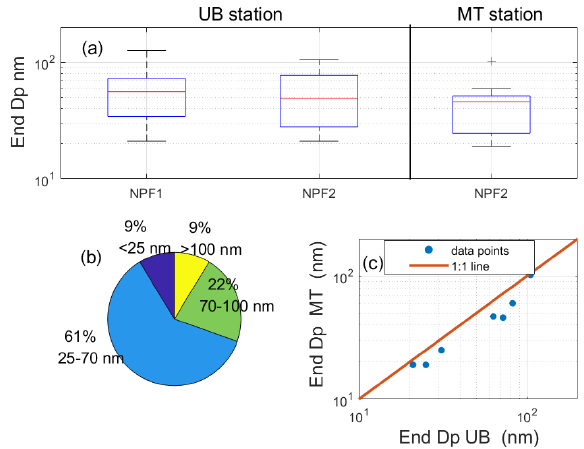
Figure 12. (a) Median and percentiles of end diameters (End Dp; nm) of NPF events measured at both sites. The red line represents the median of the data, and the lower and upper edges of the box represent 25th and 75th percentiles of the data, respectively. The length of the whiskers represents 1.5 times the interquartile range, which includes 99.3% of the data. “NPF1” and “non-event1” refer to NPF event and non-event days in summer 2018 and 2019, and “NPF2” and “non-event2” refer to NPF event and non-event days during the observation from 14 June to 14 July 2019. (b) Frequen- cies of end diameters in the size range of smaller than 25, 25–70, 70–100nm and above 100nm during our observation at the UB sta- tion in summer 2018 and 2019. (c) Comparison between end diam- eters of common NPF events at both